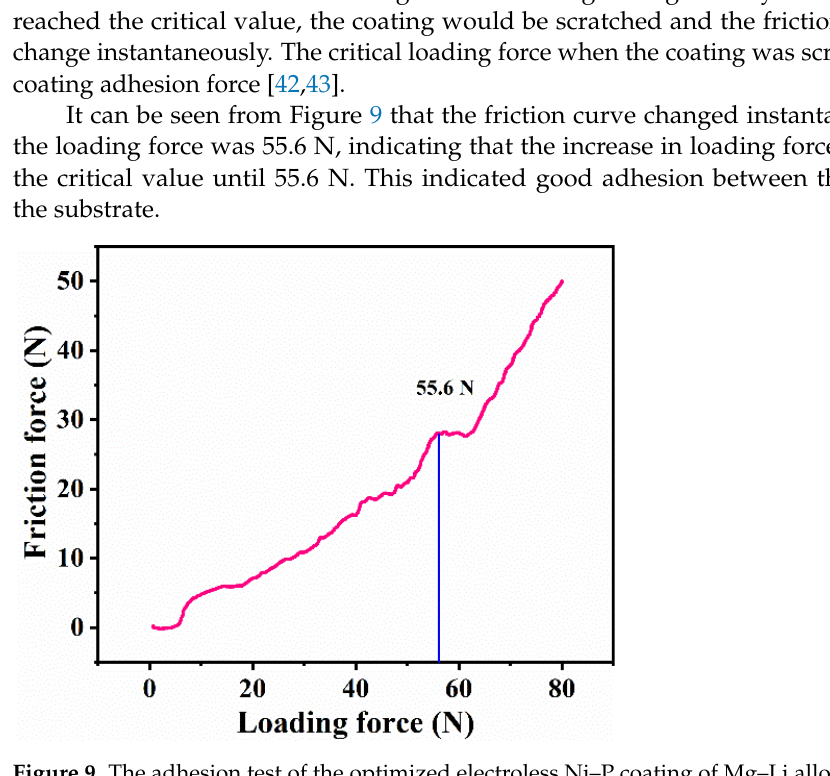
Table 3. Estimated parameters of the equivalent circuit elements for Mg–Li alloy substrate and optimized upper surface Ni–P coating.